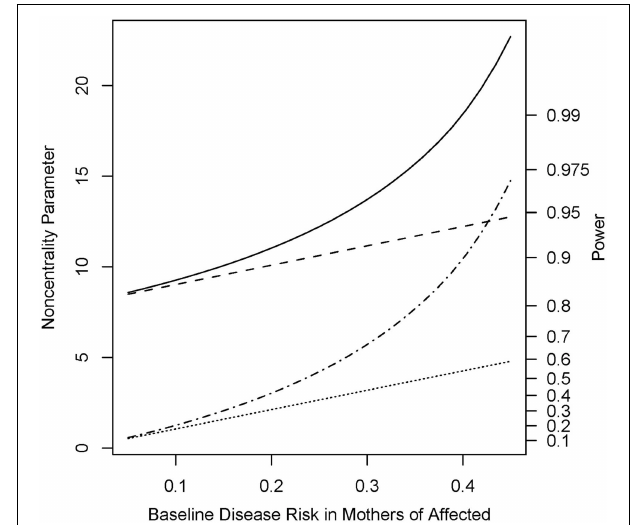
FIGURE 1 | Noncentrality parameter and power as a function of allele frequency. All designs used 300 complete triads in a homogenous population under the risk scenario: R 1 = R m 1 = 1 . 4 , R 2 = R m 2 = 1 . 96 , and S 1 = S 2 = 1 . The baseline risk in mothers of affected offspring is 0.2. Vertical axes: left, the chi-squared non-centrality parameter for a 1-df likelihood ratio test; right, power at α = 0 . 05 . Horizontal axis shows the allele frequency ranging from 0.1 to 0.9. Curves: dot, parenTDT ; dash-dot, Parent ; dash, combTDT ; solid, PPI-CT .